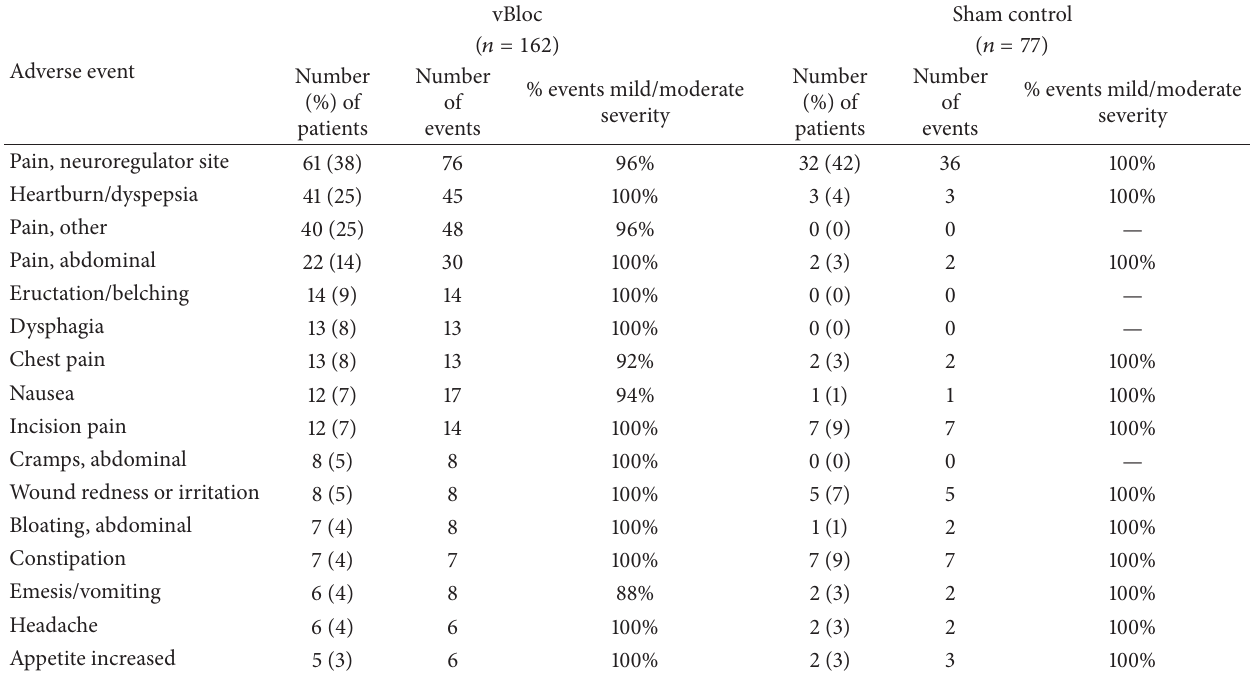
Table 3: Cumulative adverse events related to device, procedure, or therapy through 18